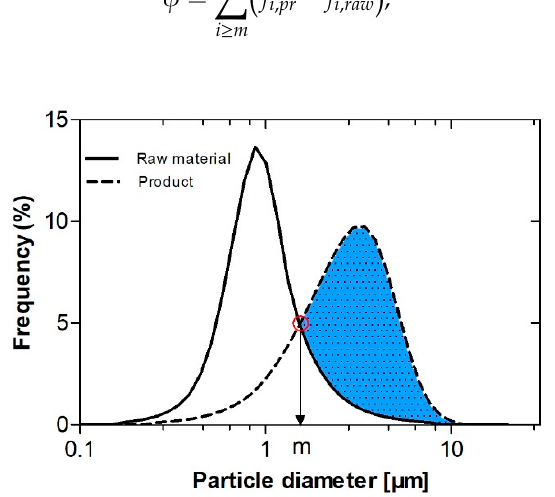
Figure 5. Principle for calculating the agglomeration ratio.